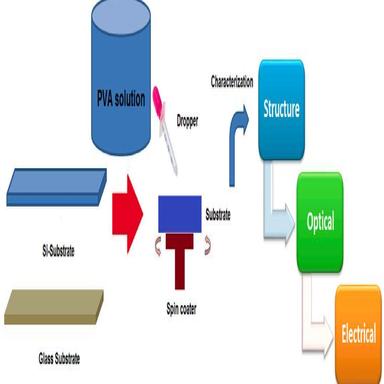
Schematic diagram of the formation and characterizations of PVA films.